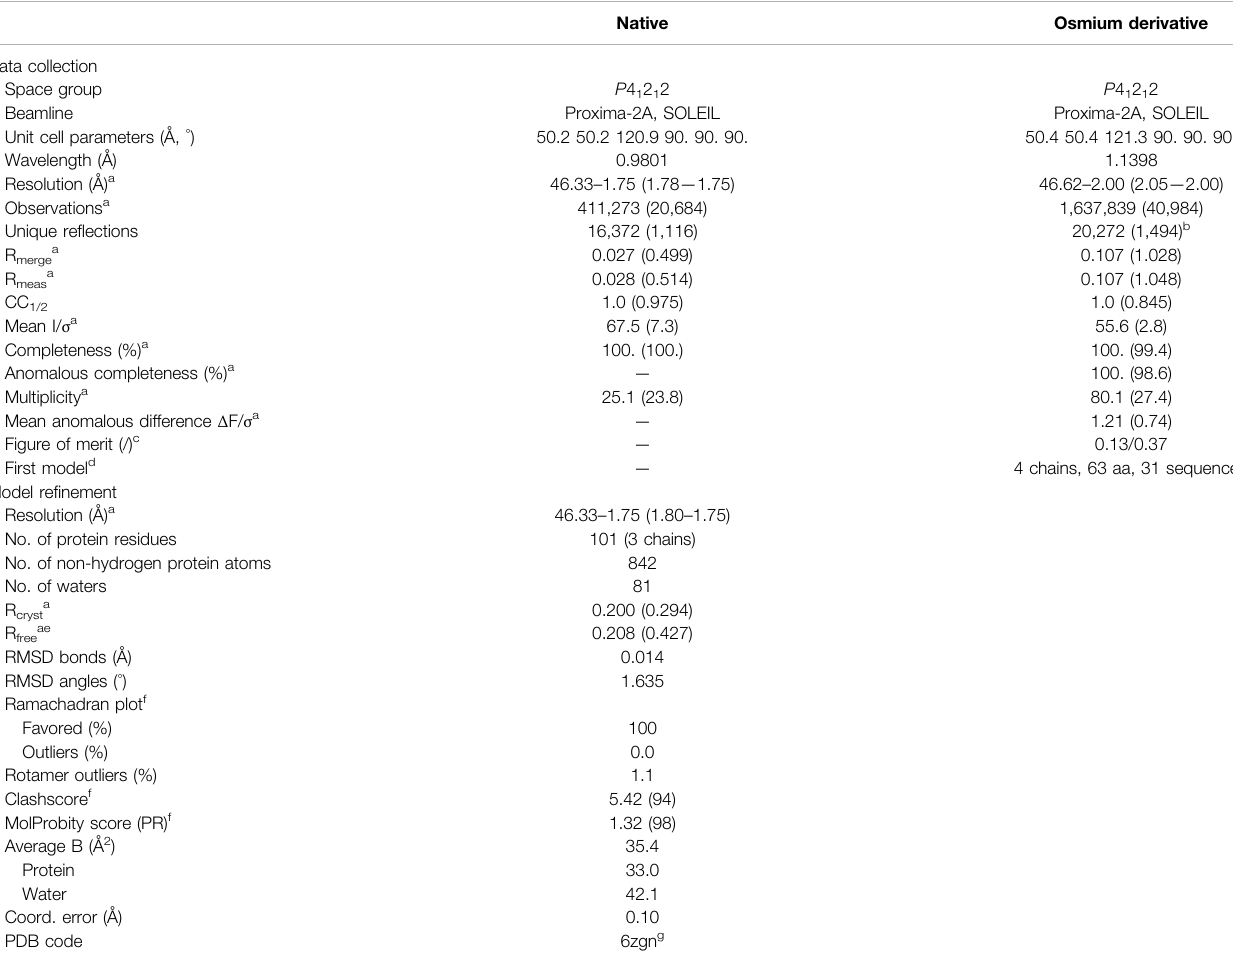
TABLE 1 | Statistics of data collection for the native crystal and for the osmium derivative crystal, and re fi nement of OrfG 64 – 204 model.